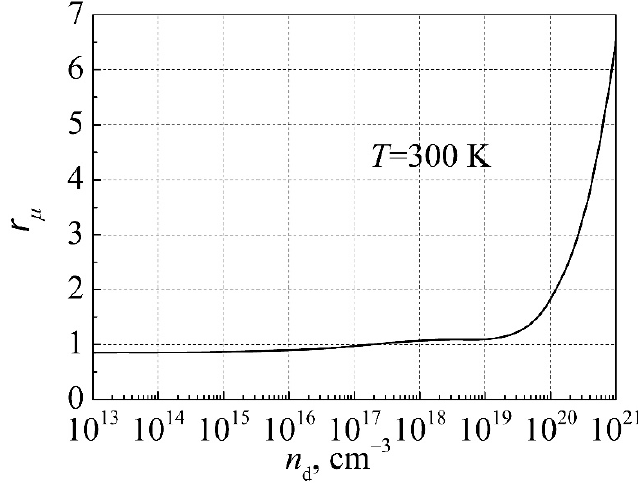
Figure 10. Mobility factor 𝑟 µ dependence on the donor density in silicon at room